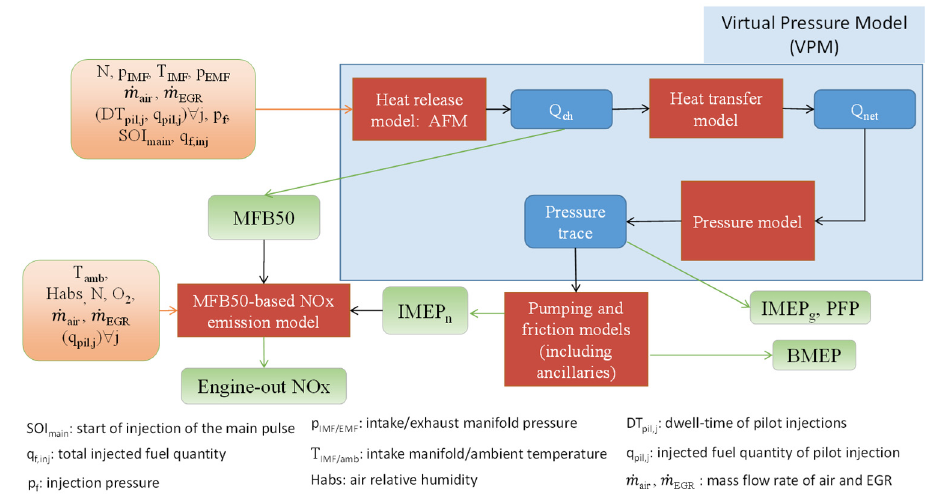
Figure 1. Schematic of the baseline combustion model [9].